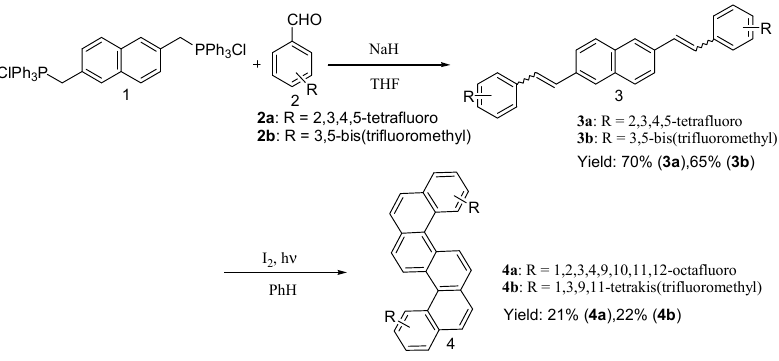
Scheme 1. Schematic representation of synthesis of title compounds.